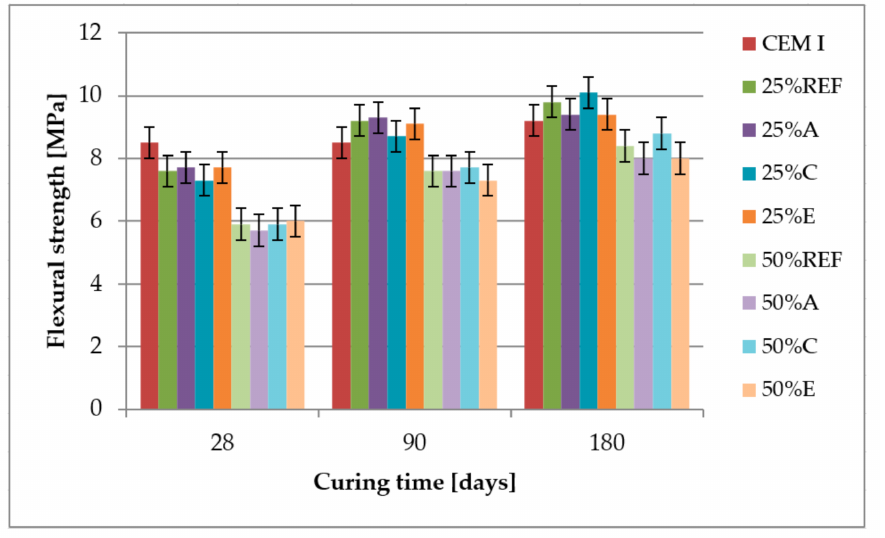
Figure 7. Flexural strength of mortars. The compressive and flexural strength of mortars containing 25% and 50% of fly ash after 28 days of curing was lower than the reference sample without fly ash. After 90 days of curing, all samples containing 25% of fly ash almost reached the values of compressive strength obtained by the reference sample, which is also shown in Figure 8, where the activity index almost reaches the value of 100%. The flexural strength of mortars containing 25% of fly ash after 90 days of curing is from 2% to 9% higher than the reference values. After 180 days of curing, compressive and flexural strength increases for an additional 10%. Mortars containing 50% of fly ash did not reach the strength of the reference sample even after 180 days of curing.